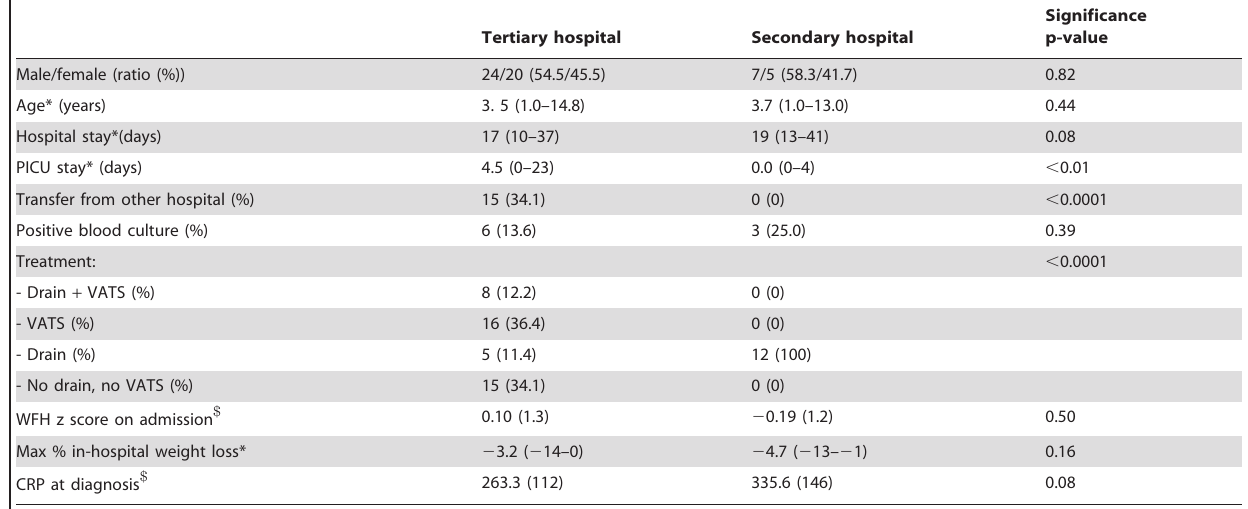
Table 1. Patient characteristics.